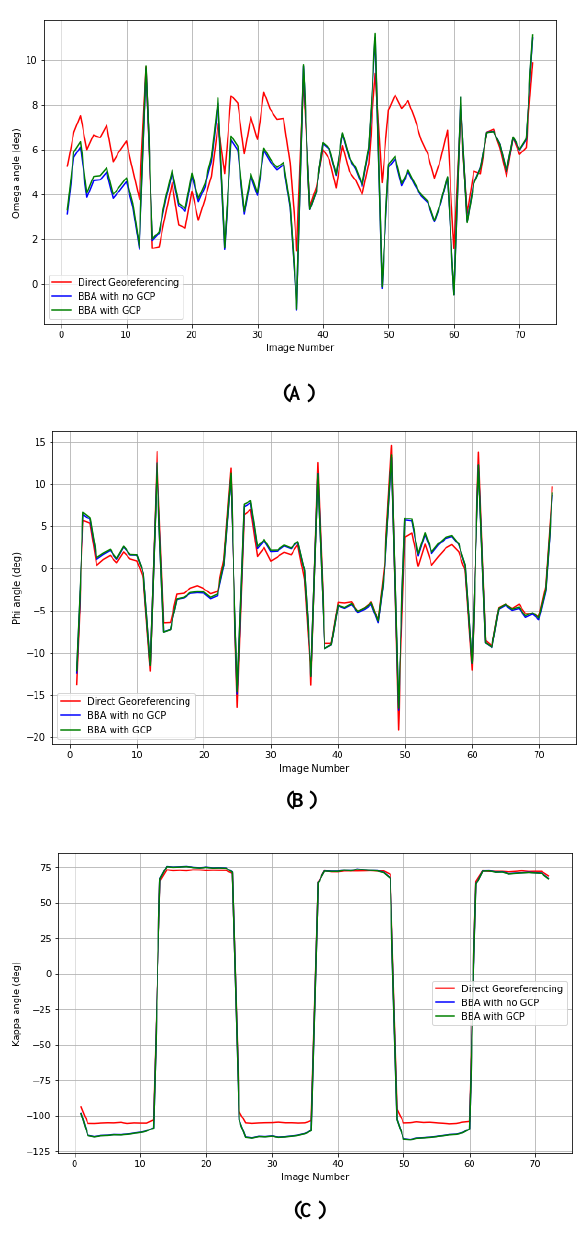
Figure 7. Comparison of attitude angles in (A) Omega, (B) Phi and (C) Kappa between Direct Georeferencing (Red), BBA with no GCP (Blue) and BBA with GCP (Green)